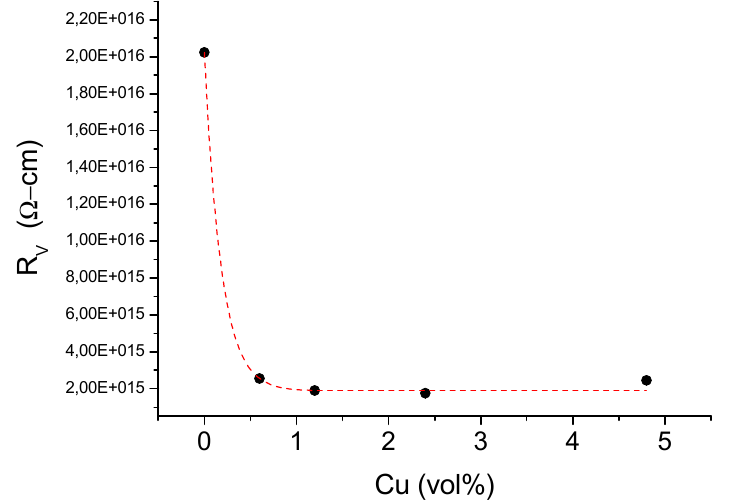
Figure 5. Volume resistivity (R v ) versus copper content in ABS.